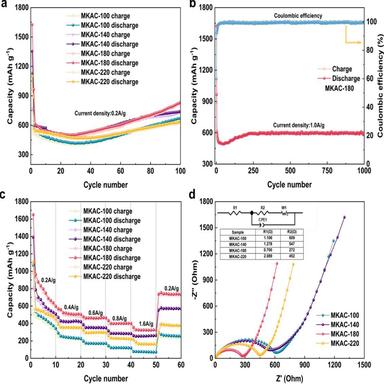
(a) Cycle performance at 0.2A/g, (b) Cycle performances of the MKAC-180 anode at the current density of 1.0A g− 1 after 1000 cycles, (c) Rate performance at 0.2, 0.4, 0.6, 0.8, 1.6 A⋅g− 1 and back to 0.2 A⋅g− 1 , (d) Electrochemical impedance spectra profiles in a frequency range of 0.01 to 100 kHz of the MKAC-T anodes prepared by four different solvothermal temperature.